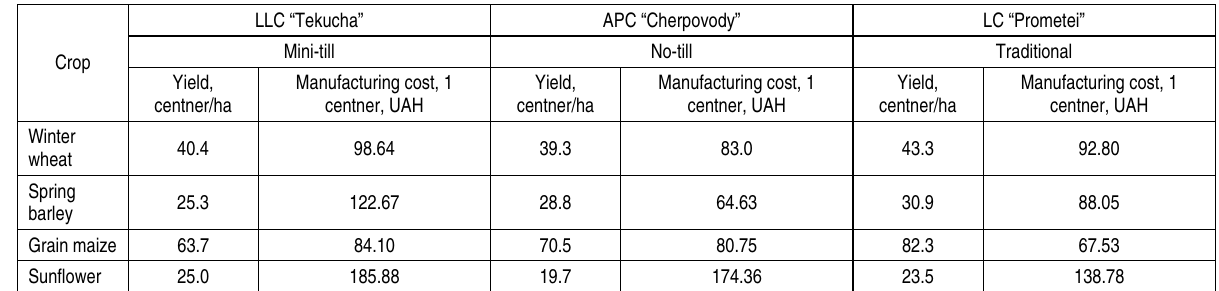
Table 6. Productivity and cost of production of agricultural crops at the enterprises of Uman district of Cherkasy region for 2013-2016